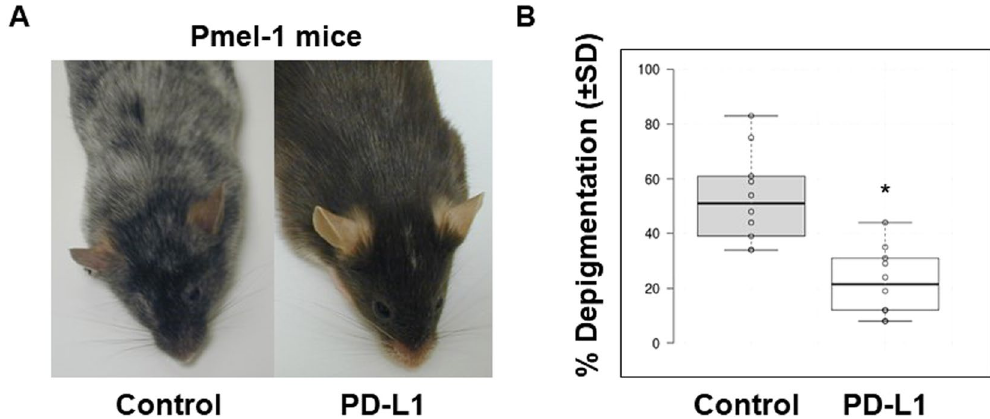
Figure 1. PD-L1 fusion protein treatment significantly reduces pigment degradation in adult Pmel-1 mice. Pmel-1 mice with pigment loss conditions (21 weeks) were treated with mouse PD-L1 fusion protein or IgG control for 6 weeks. Photographs were taken 1 week after the last treatment. ( A ) Pigment loss of representative mice after treatment. ( B ) Quantification of all mice 3 weeks after the last treatment (Control group n = 9 cases, PD-L1 protein treated group n = 8 cases, * p <